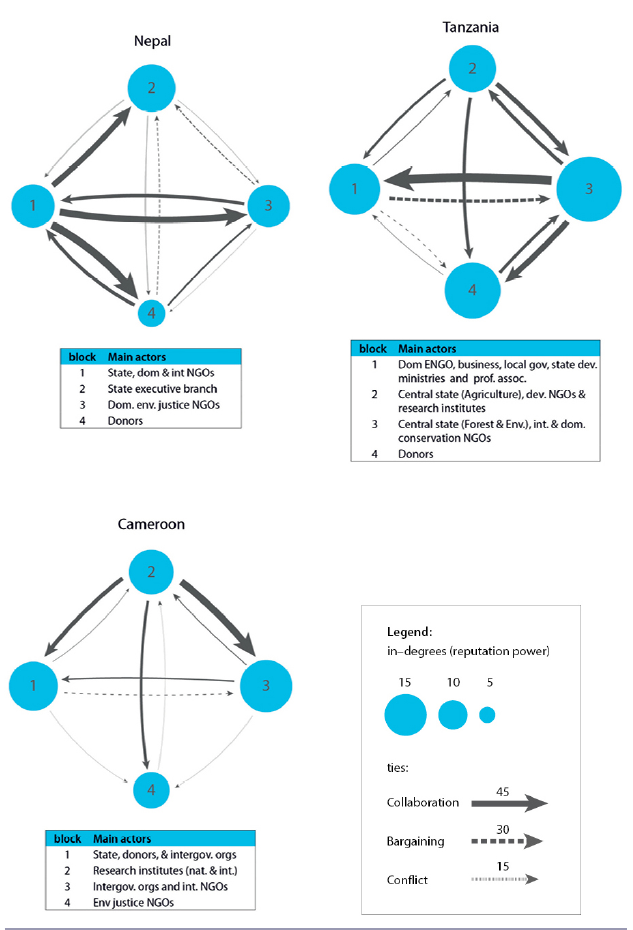
Fig. 4 . Patterns of interactions in national REDD+ policy domains.